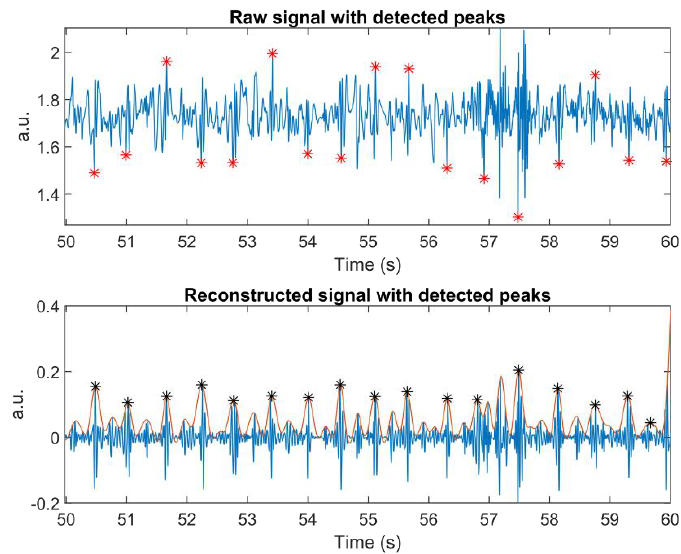
Figure 9. Detect uses wavelet transform to decompose signals based on the similarity of their shape with the mother wavelet. It offers the possibility to detect peaks, shown as asterisks that are hard to find even for a human.